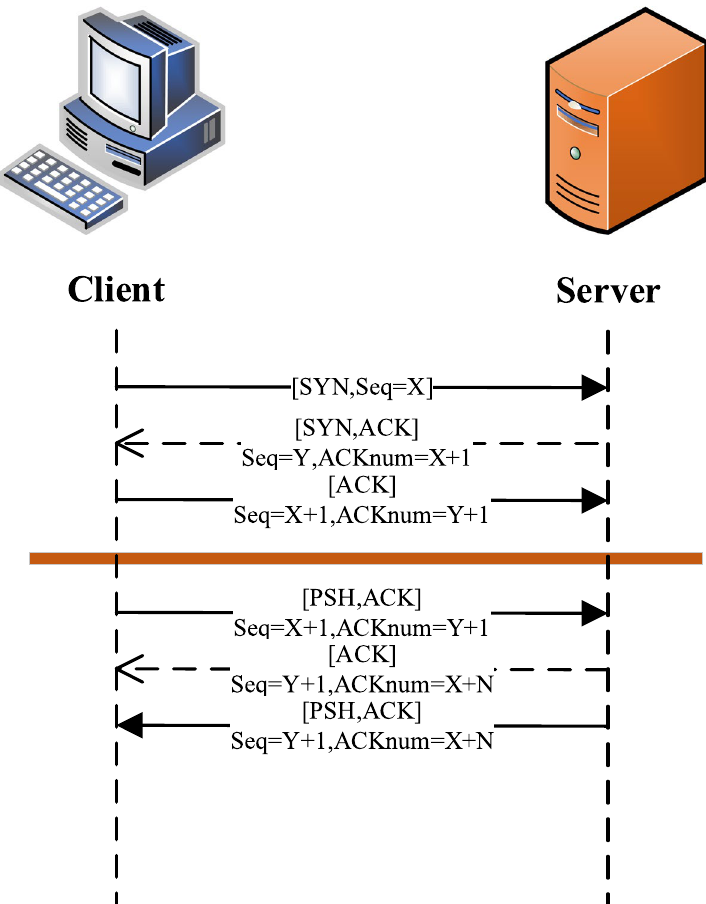
Fig. 5 Flow chart of TCP connection and data